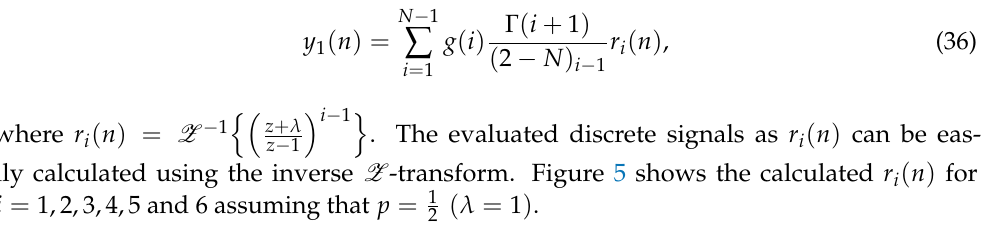
Figure 5. ( a – f ) Plots of signal r i ( n ) for i = 1,2,3,4,5, and 6 assuming that p = 1